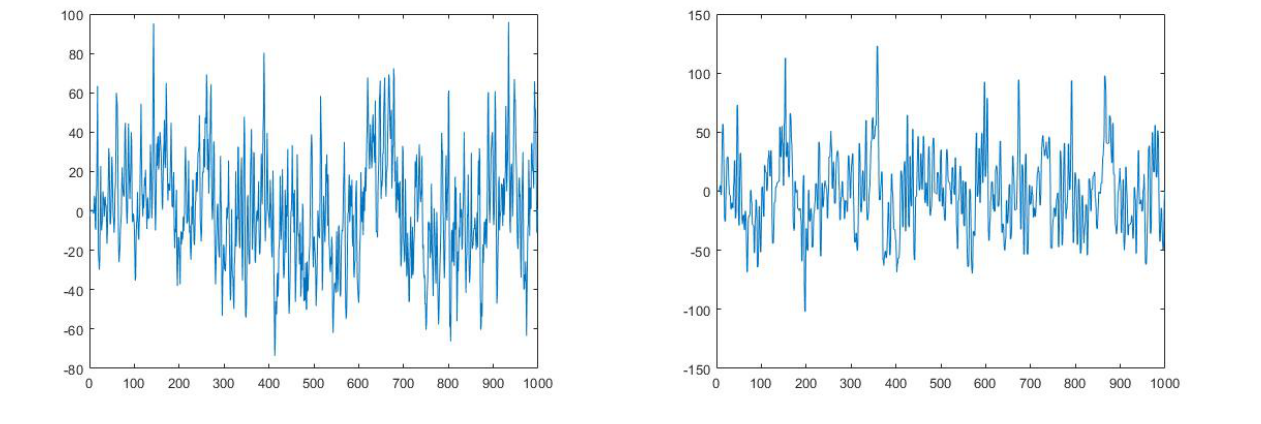
Figure 8. chb02-02 OWA Output